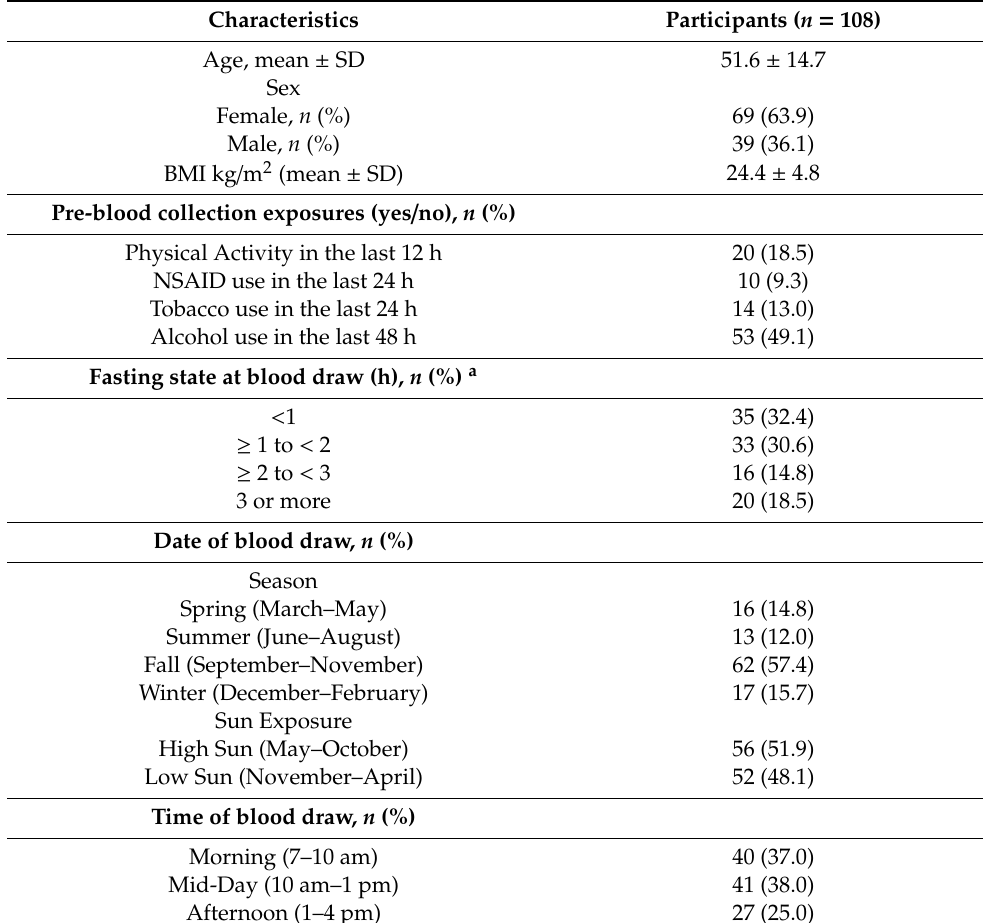
Table 1. Characteristics and pre-blood collection exposures for participants from the PRÄVENT cohort ( n =